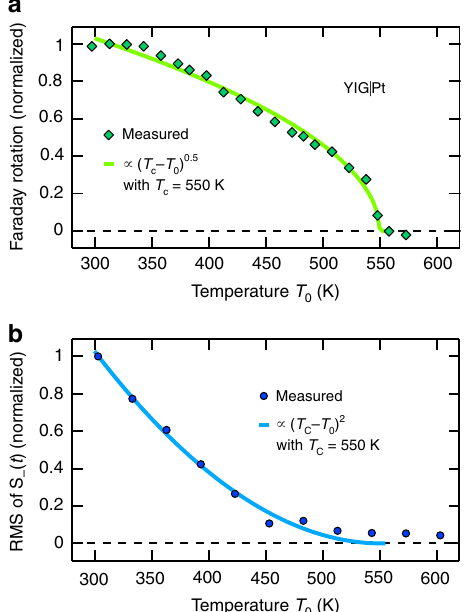
Fig. 3 Effect of sample temperature. a Faraday rotation of a continuous- wave laser beam (wavelength 532 nm) after transmission through a YIG(3 µ m)|Pt(5.5 nm) sample as a function of the sample temperature. (cid:3) T ð Þ α (ref. 33 ) yields a critical exponent of α = 0.5 A fi t proportional to T 0 C and a Curie temperature of T C = 550 K. b Temperature dependence of the amplitude of the magnetic THz emission signal S − , which differs from that of the sample magnetization, similar to previous work on the (cid:3) T ð Þ α , here yielding DC SSE 32 . The solid line is a fi t proportional to T 0 C α = 2.0 ±